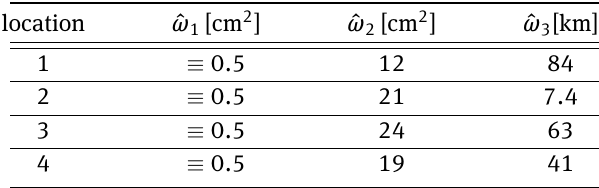
Table 1: The covariance parameters ω i of Eq. (22) are estimated at the specified locations of Fig. 1 using the 150 closest